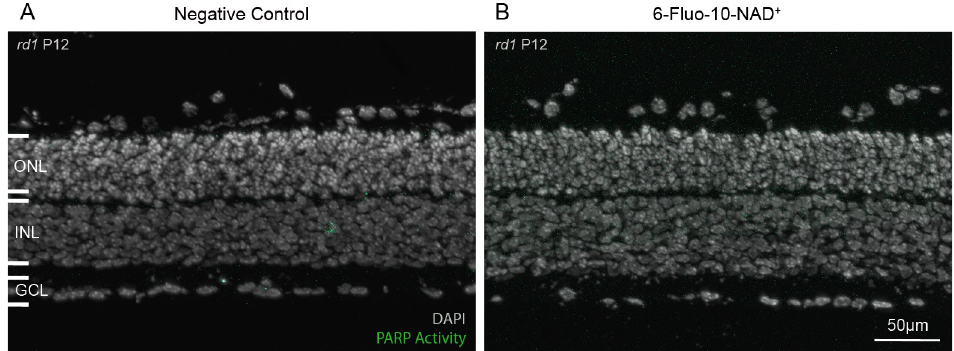
Fig 5. The 6-Fluo-10-NAD + analogue does not allow live tissue detection of PARP activity. Live, organotypic retinal explant cultures were incubated with 100 μ M 6-Fluo-10-NAD + from P11 to P12 (24h). No fluorescent signal was observed within the retina, indicating that the NAD + analogue may not have penetrated live cells. DAPI was used as nuclear counterstaining. ONL = outer nuclear layer, INL = inner nuclear layer, GCL = ganglion cell layer. Images representative for results obtained from 5 independent retinal explant